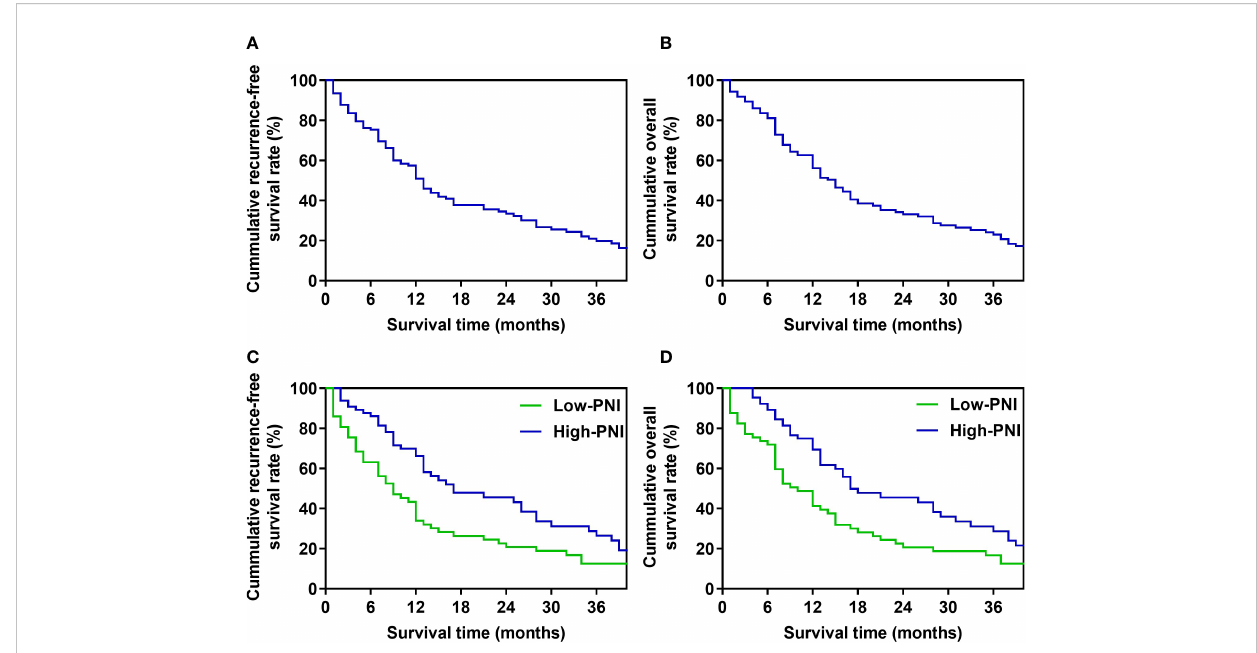
FIGURE 1 Survival curve of patients (A) . Recurrence-free survival curve of the whole study ’ s patients. (B) . Overall survival curve of the whole study ’ s patients. (C) . Recurrence-free survival curve of high-PNI and low-PNI groups. (D) . Overall survival curve of high-PNI and low-PNI